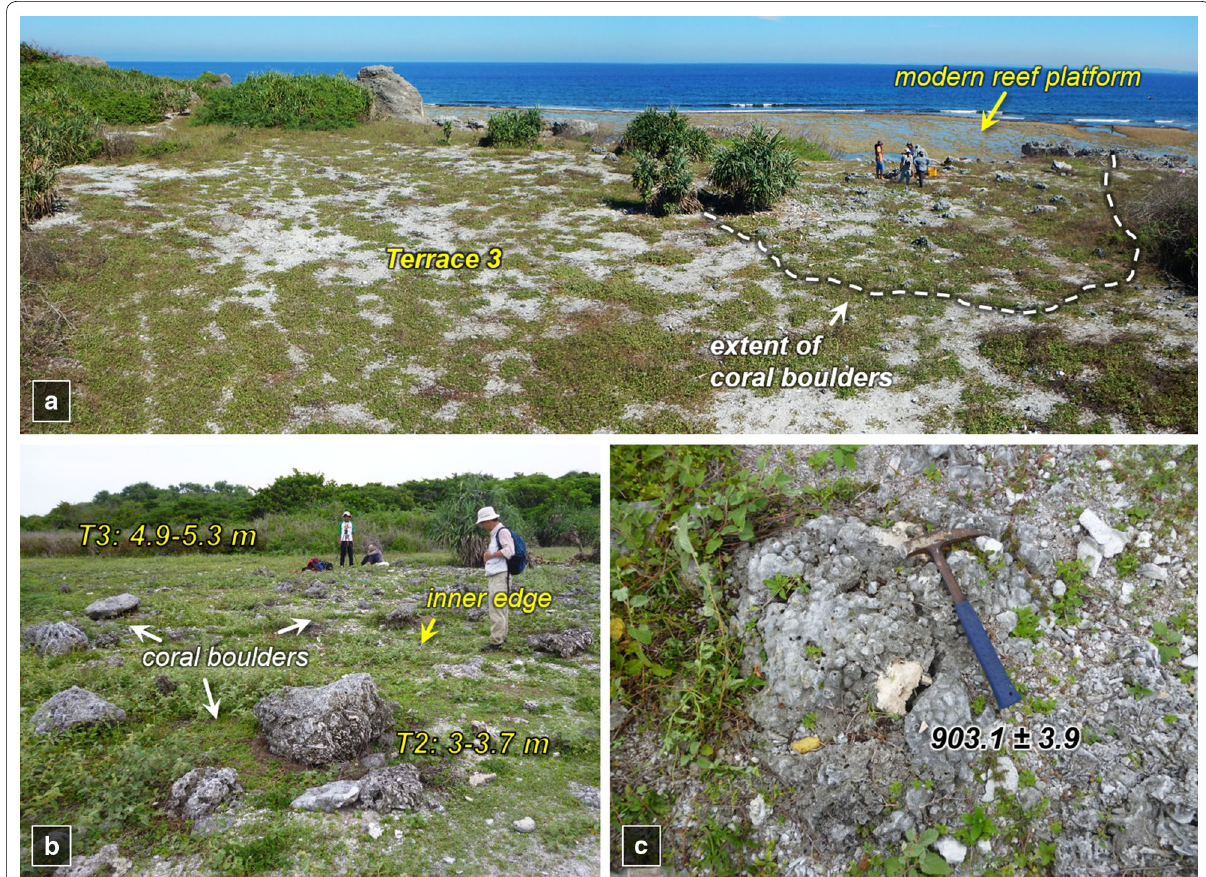
Fig. 3 Representative photos of the survey site showing the occurrence and distribution of the coral boulders. a T3 rises to about 5 m amsl and is buried by sand, shells and shell fragments, and coral debris. Coral boulders are generally distributed close to the inner edge of T2 and just above the outer edge of T3. b Coral boulders on T2 and T3 are mostly individual corals, while the larger blocks are often cemented fragments of branching corals. c One of the young fossil corals, presumably Porites , sampled among the coral boulders on top of T3 yielded an age of 903.1 fossil coral sample nearby yielded an age of 945.1 4.6 years BP ±